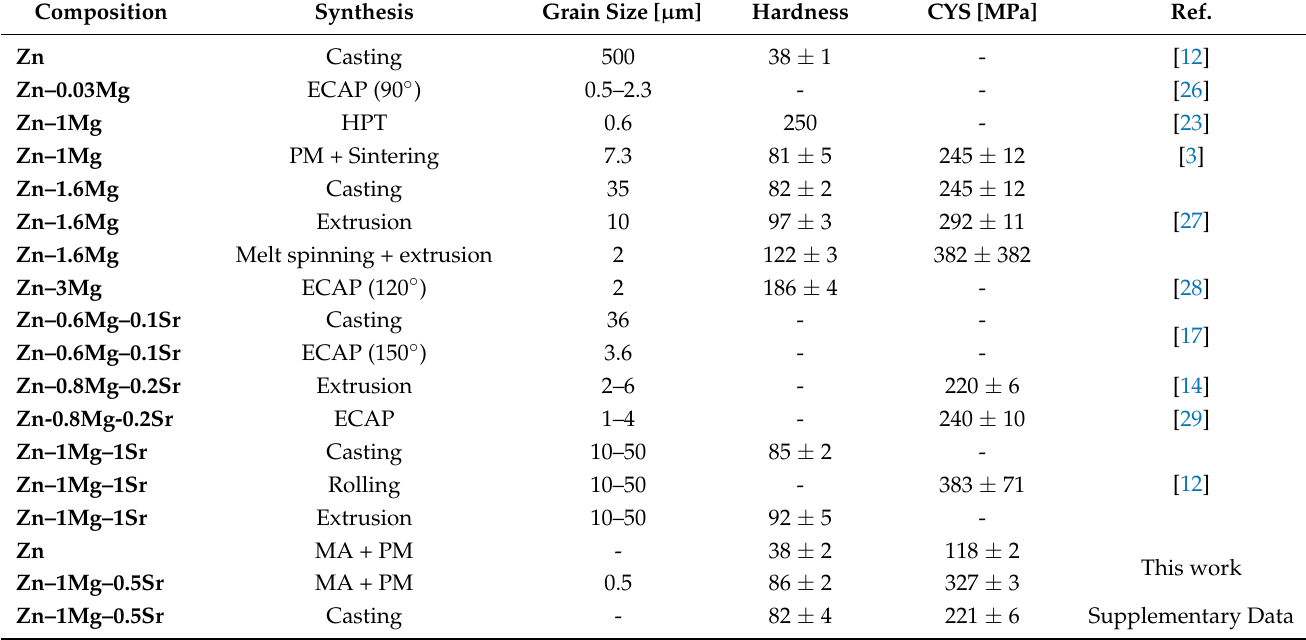
Table 2. Key characteristics of selected Zn-based alloys with close composition to